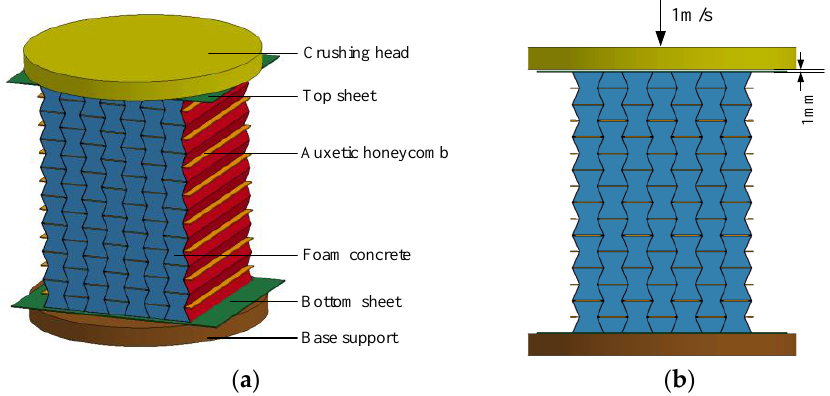
Figure 5. The numerical model: ( a ) model configuration; ( b ) loading mode.